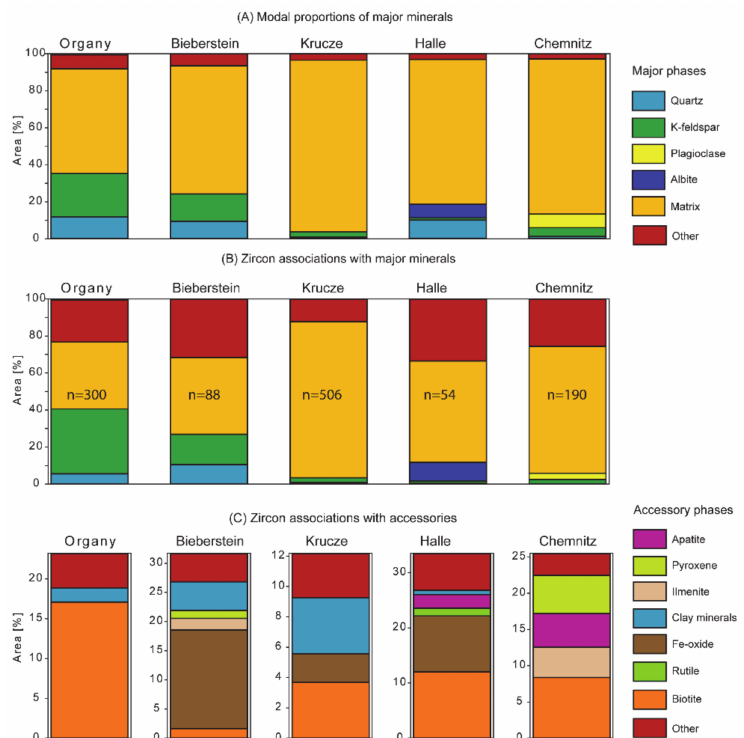
Figure 3. Modal composition and proportions of minerals associated with zircon as calculated by Mineral Liberation Analysis software. ( A ) Modal proportions of major minerals in the studied rocks; ( B ) zircon associations with major minerals in the studied rocks ( n is the number of zircon grains detected in each sample by MLA-SEM); ( C ) zircon associations with accessory minerals in the studied